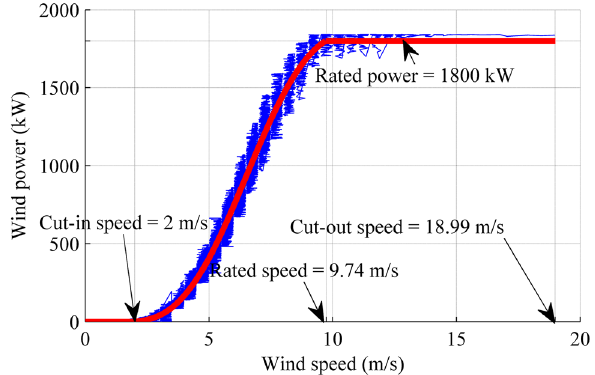
Figure 8. Wind power curve. The simplest data cleaning method is to delete the wind power data that lies outside the boundary. Blue zone line is wind power curve after pre-processing of raw wind power data, while red line is the fitting line for wind power data. Figure created using Matlab R2014a (https:// www. mathw orks.